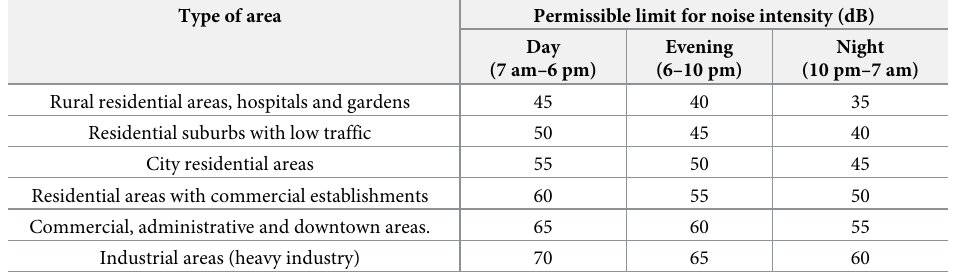
Table 1. Egyptian noise standards and policy on the maximum permissible limit for noise intensity Leq (dB) in different land use areas according to the Egyptian Environmental Law No. 4/1994